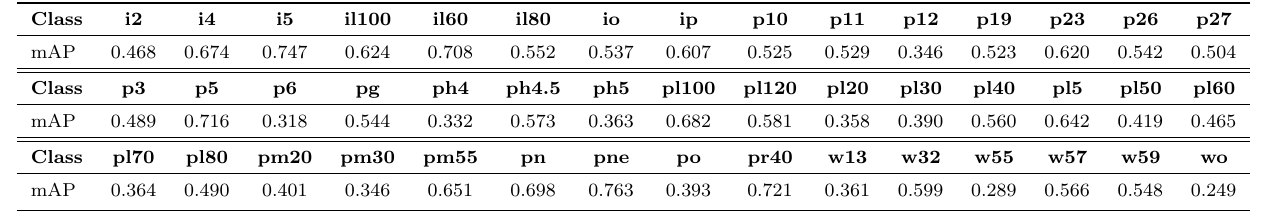
Table 4 Performance (using the fastest model trained) over 45 categories having more than 100 instances. mAP of different classes varies greatly due to varying numbers of instances and difficulty of extracting features. Classes with distinct geometrical characteristics (for instance, pne and pn), are easier to recognize, while triangular signs are harder to distinguish